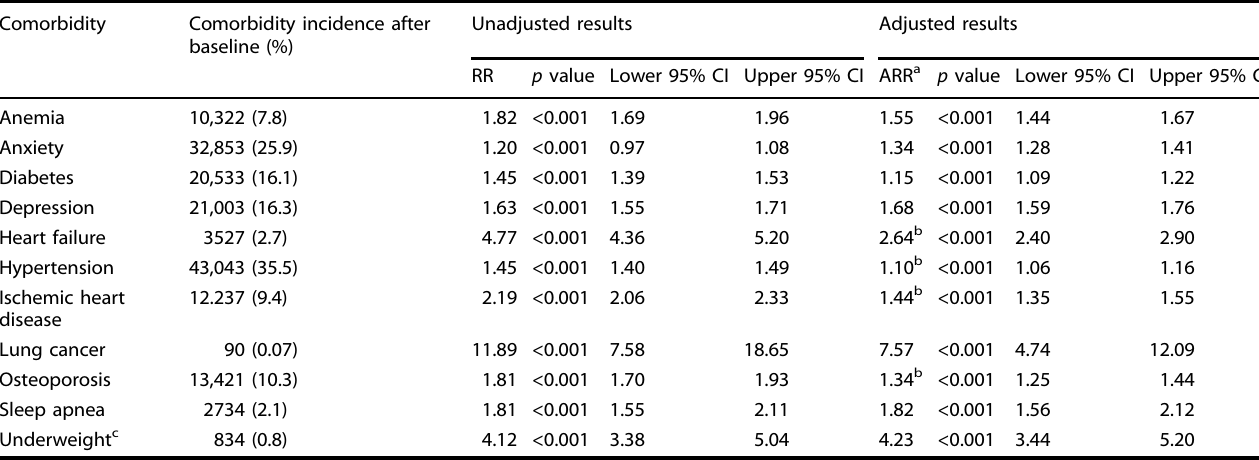
Table 2. Relative risk for patients exposed to COPD compared to patients unexposed to